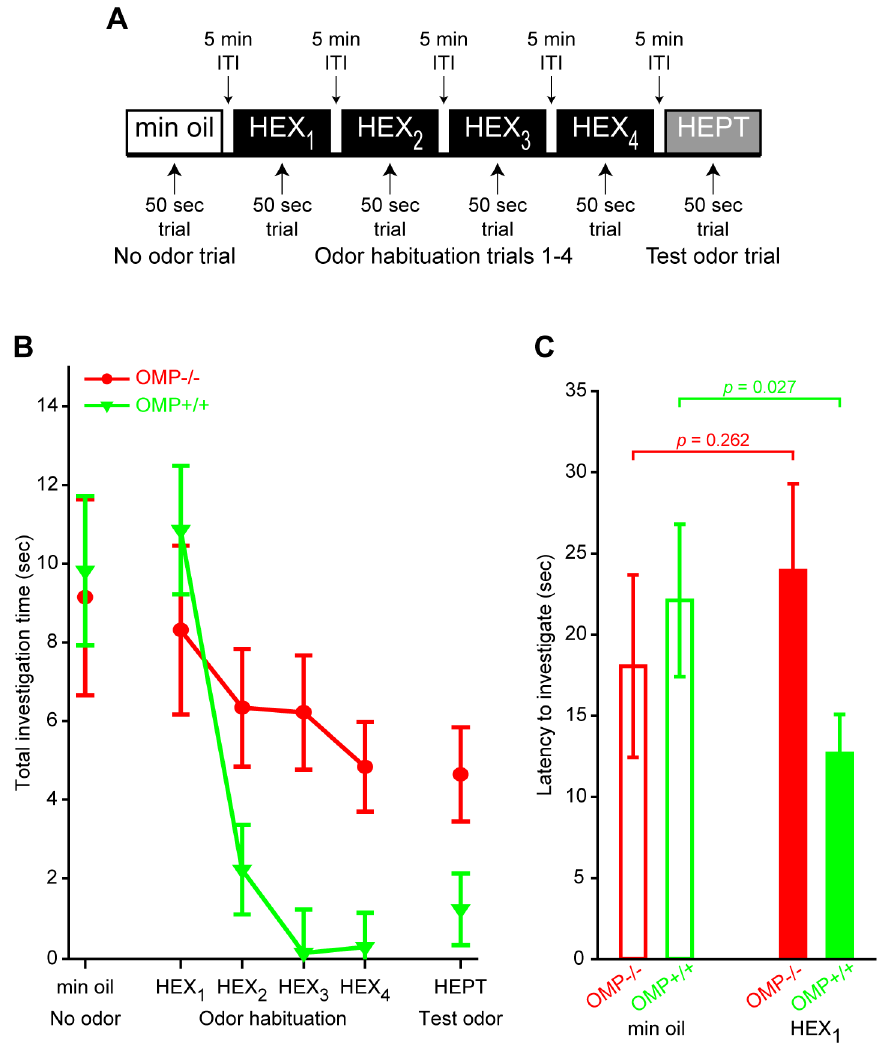
Figure 5. Non-associative odor-induced behaviors are altered in OMP 2 / 2 mice. ( A ) Procedure summary of behavioral testing protocol. ( B ) Mean ( 6 SEM) duration of stimulus investigation (sec) plotted as a function of trial type. ( C ) Mean ( 6 SEM) latency (sec) to begin investigating the mineral oil (no odor) stimulus ( open bars ) and the HEX stimulus ( solid bars ) during the first and second trials, respectively, of the paradigm shown in A . In B and C OMP 2 / 2 mice and OMP + / + mice are shown in red and green ,